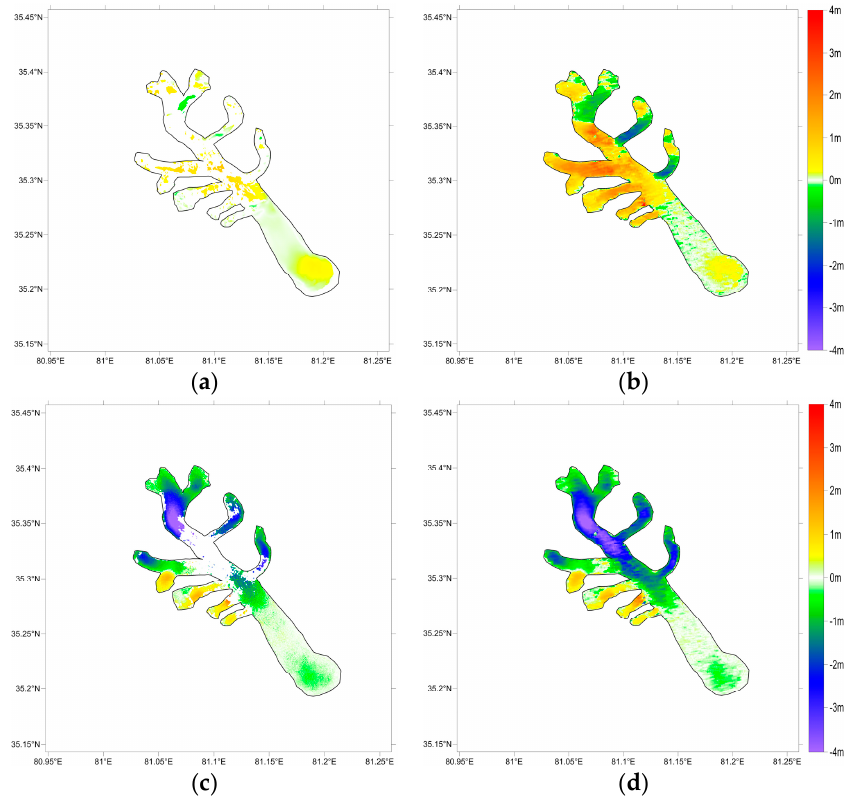
Figure 4. Results of D-InSAR, MAI, and PT during the temporal period of 23 December 2008–28 January 2009. ( a ) D-InSAR unwrapping result; ( b ) PT result in the LOS direction; ( c ) MAI unwrapping result; and ( d ) PT result in the along-track direction.